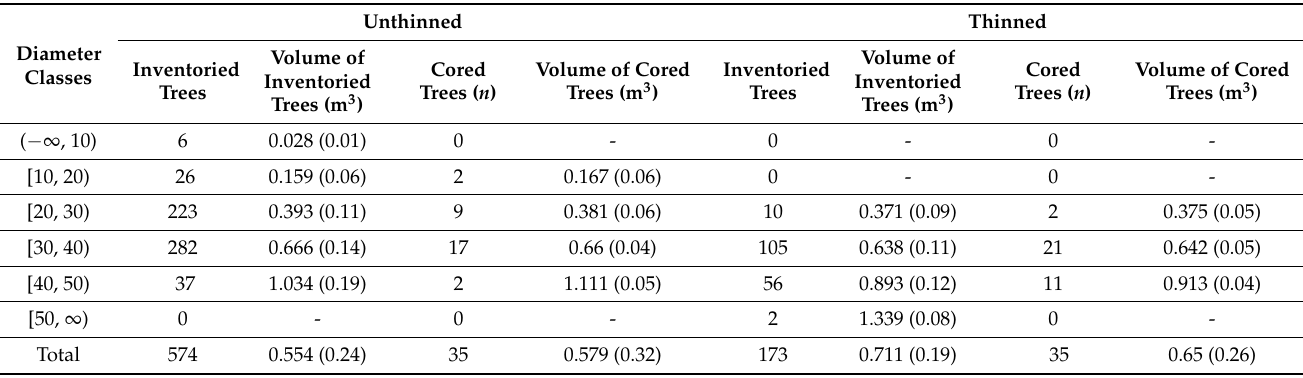
Table 2. P. patula sample trees (February 2013) based on outside bark volume from inventoried data (January 2013). Standard deviations are provided in